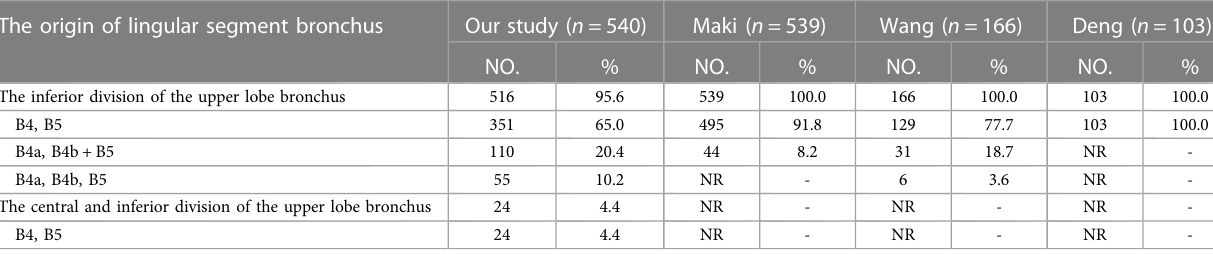
TABLE 1 Branching patterns of the lingular segment